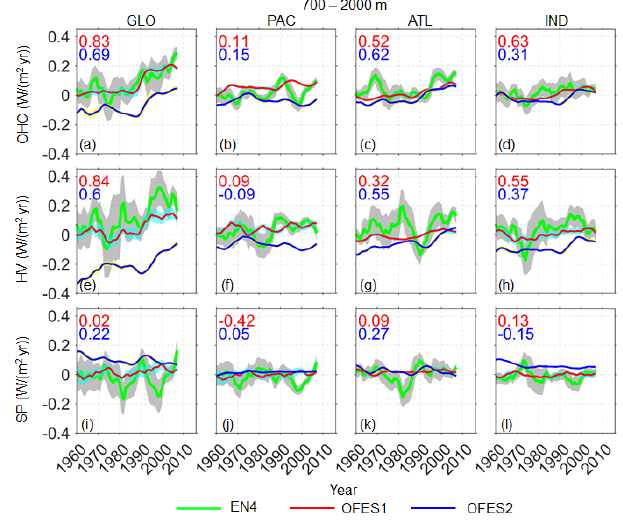
Figure 7. As for Fig. 6 but for the lower layer